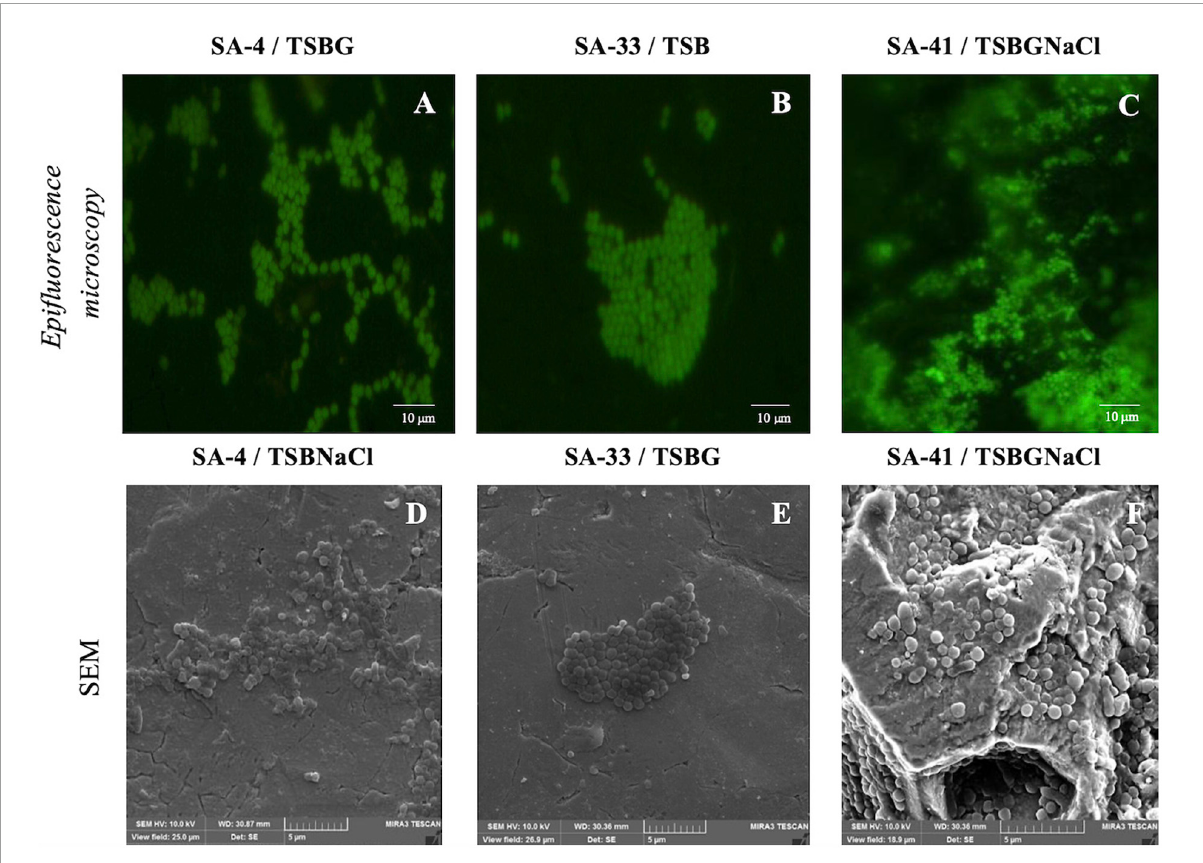
FIGURE2 Biofilms of isolates S. aureus [SA-4 (A,D) , SA-33 (B,E) , and SA-41 (C,F) ] from food contact surfaces (FCS). Biofilms were developed on stainless steel through 192 h of incubation in different medium at 37 ◦ C and visualized with epifluorescence microscopy (top row) and SEM (bottom row). SA, S. aureus ; TSB, Tryptic soy broth; TSBG, TSB + 0.4% Glucose; TSBNaCl, TSB + 4% NaCl; TSBGNaCl, TSB + 0.4% Glucose + 4%